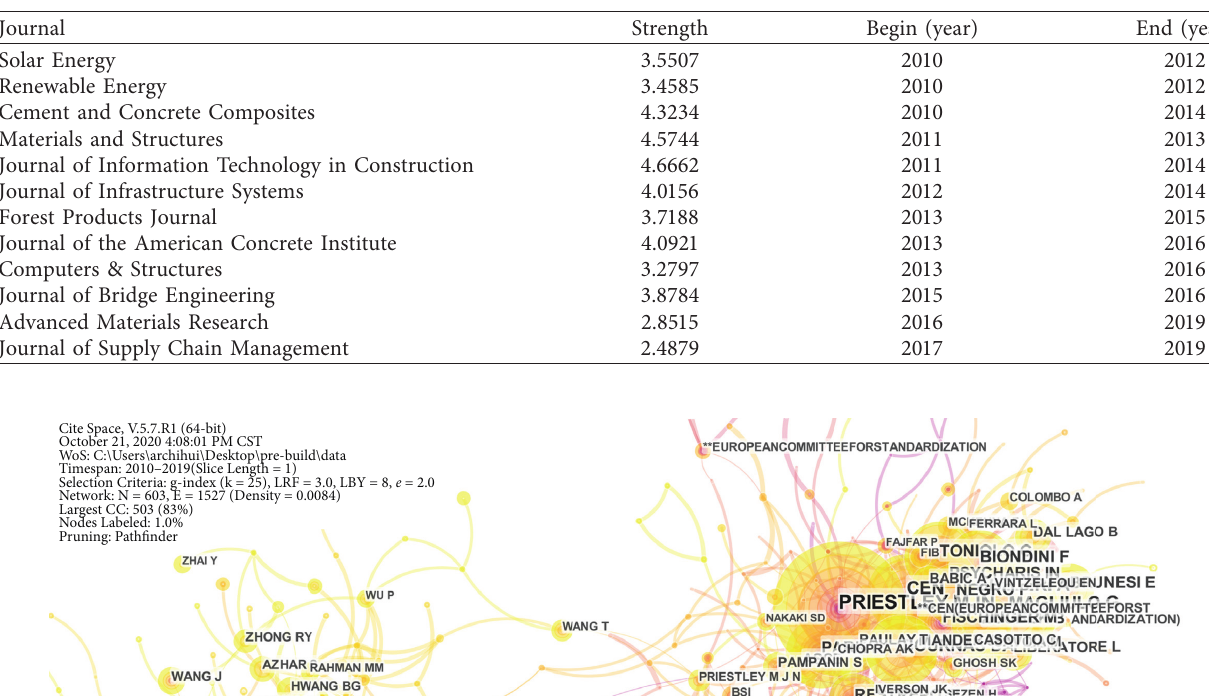
Table 7: Top 12 journals’ co-citation with the strongest citation bursts in each corresponding period.